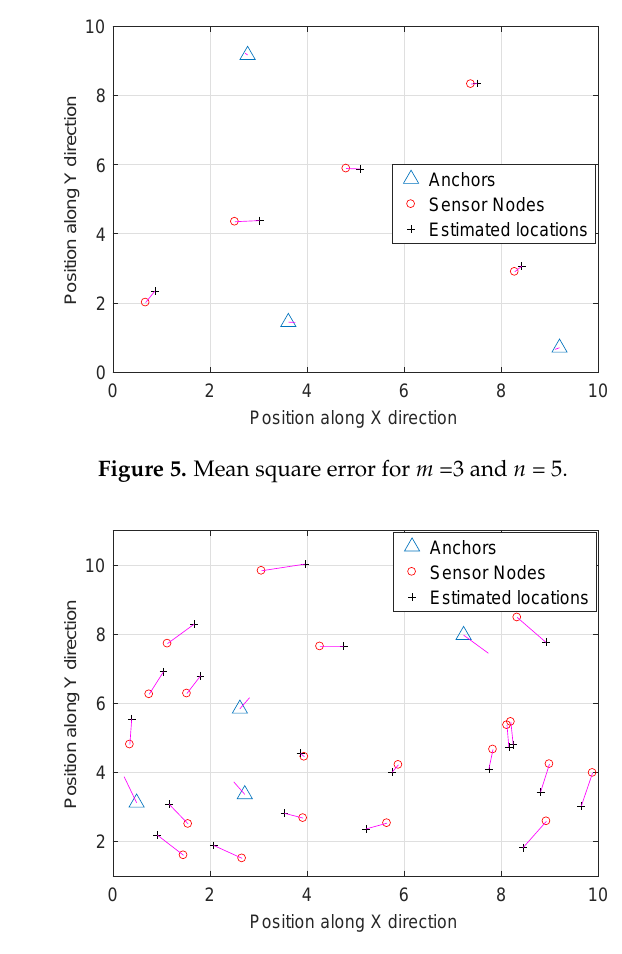
Figure 6. Mean square error for m =4 and n =